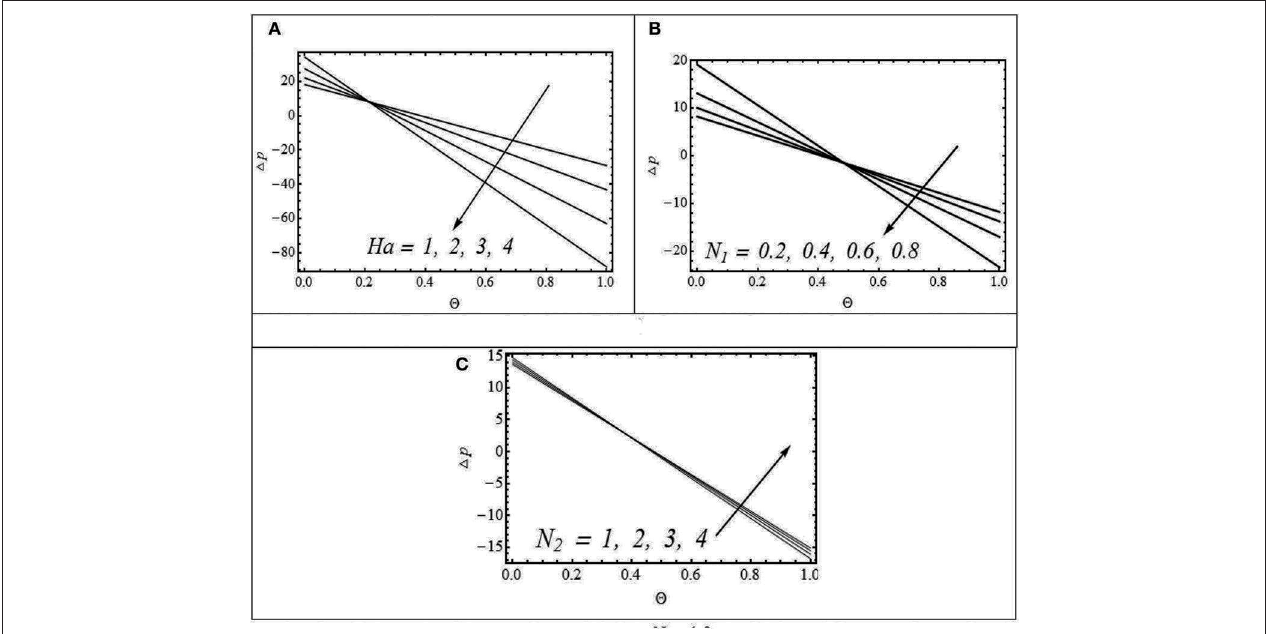
FIGURE 5 | (A) Impact of Ha on 1 p with N 1 = 0.5, N 2 = 1.2, γ = 2.5, and λ = 0.4. (B) Impact of N 1 on 1 p with γ = 2.5, N 2 = 1.2, and λ = 0.4. (C) Impact of N 2 on 1 p with N 1 = 0.5, γ = 2.5, and λ = 0.4.